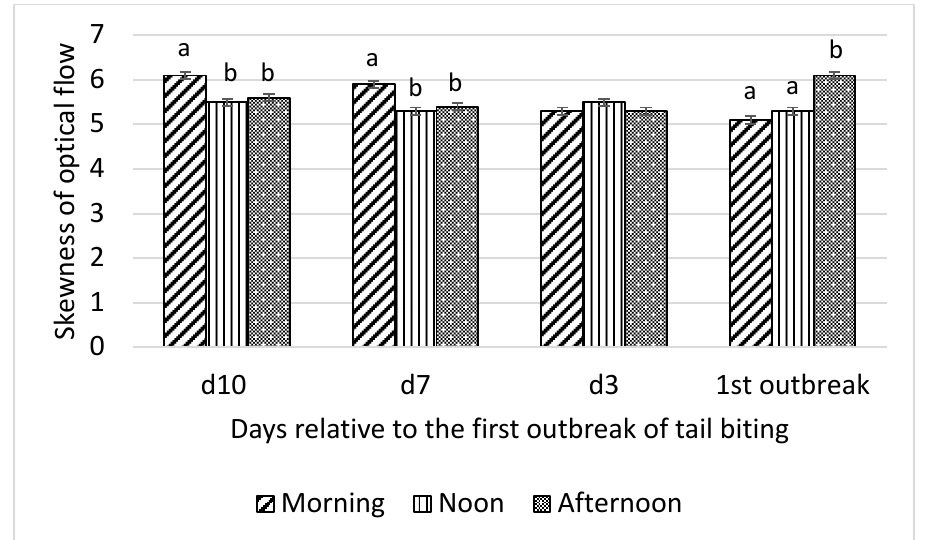
10 of 17 Figure 2. Interaction between day (10 d, 7 d, and 3 d before and during) relative to the first outbreak of tail biting and time of day (morning, noon, and afternoon) for variance of optical flow; ab —within days means without a common superscript differ ( p < 0.01). Skewness of optical flow was higher in the morning than at noon and in the afternoon on day 10 and